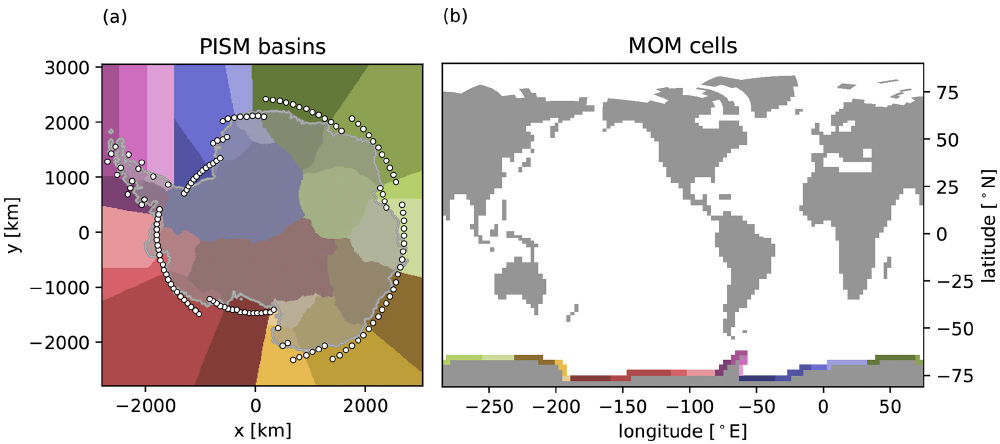
Figure 6. Visualization of the mapping mechanism between (a) PICO basins and (b) MOM5 ocean cells. PICO basins on the ice sheet grid are shown in panel (a) , with each basin assigned a different colour. The location of the centre of southernmost ocean cells is denoted by white circles. As a spatial reference, the ice cover modelled by PISM is shown in grey. Panel (b) shows the MOM5 land–ocean mask with corresponding PICO basin colours for the southernmost ocean cells surrounding the Antarctic Ice Sheet. Grey cells are considered as land in